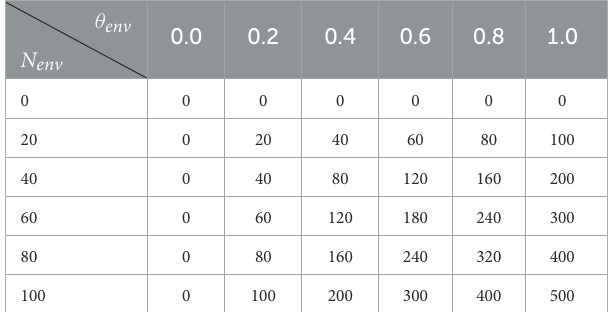
TABLE 9 Cost by level of environmental sensibilisation ( θ env ) and number of farmers concerned ( N env